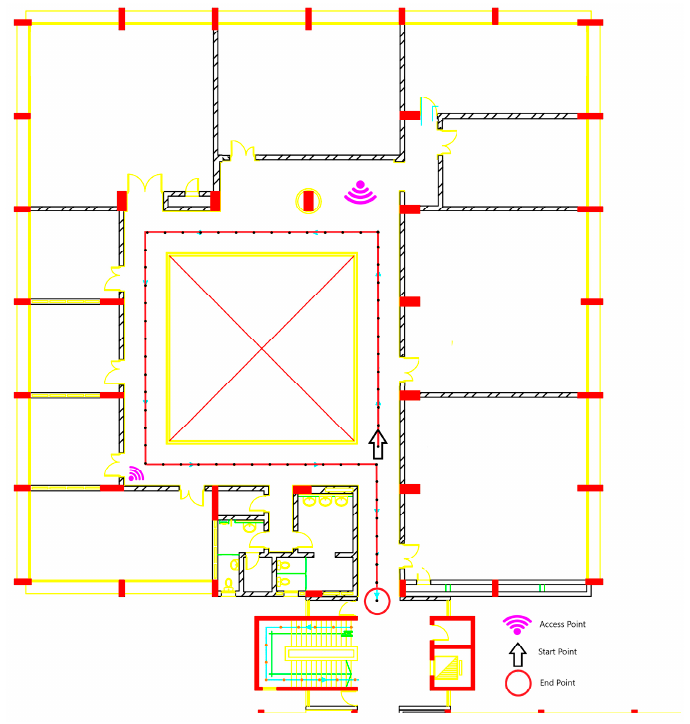
Figure 2. The layout of the residence where the second experiment was conducted.